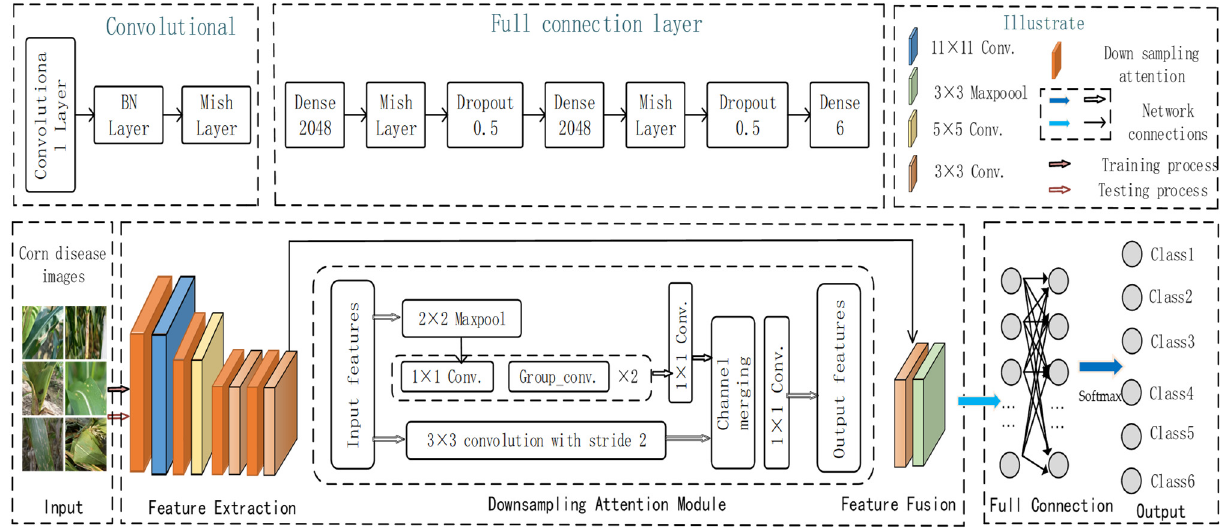
Figure 2. The overall framework of the corn disease identification algorithm.